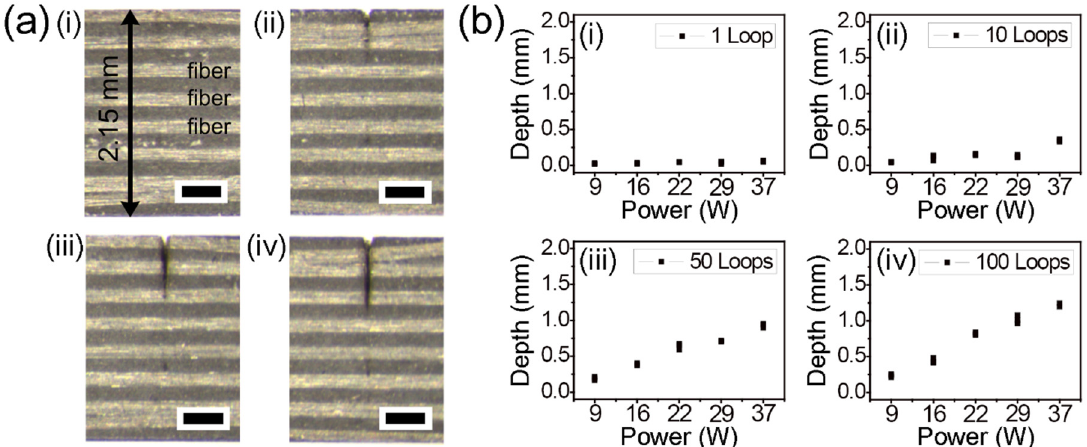
Figure 2. Picosecond laser cutting of thermoset CFRP with lateral single-pass processing. ( a ) Stereoscopic microscope cross-section images by a power of 22 W and (i) 1 loop, (ii) 10 loops, (iii) 50 loops, and (iv) 100 loops, respectively. Each scale bar = 400 µm. ( b ) Systematic investigation of cutting depths by power variation and the number of loops variation with (i) 1, (ii) 10, (iii) 50, and (iv) 100. The common experimental condition was a scan speed of 0.5 m/s.